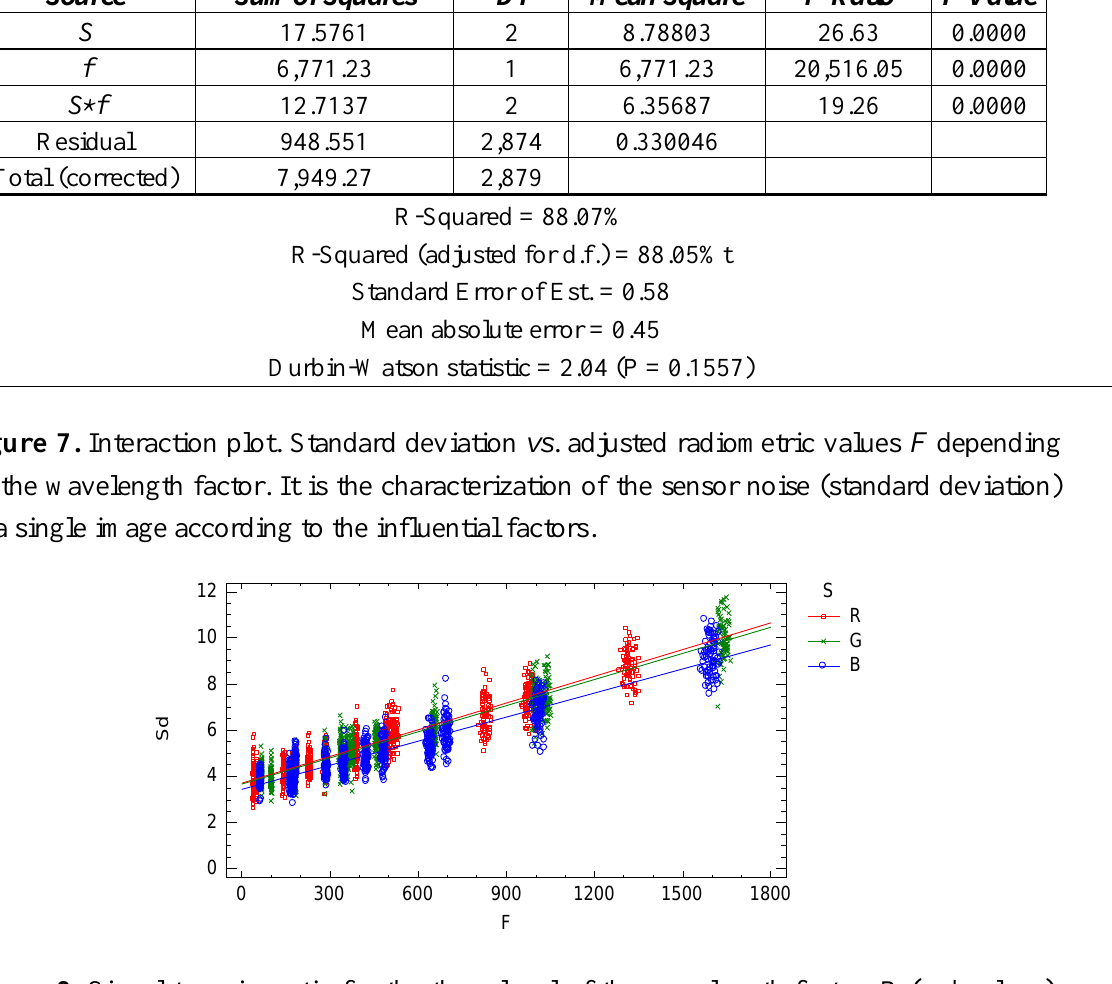
Figure 8. Signal to noise ratio for the three level of the wavelength factor: R (red colour), G (green colour) and B (blue colour).